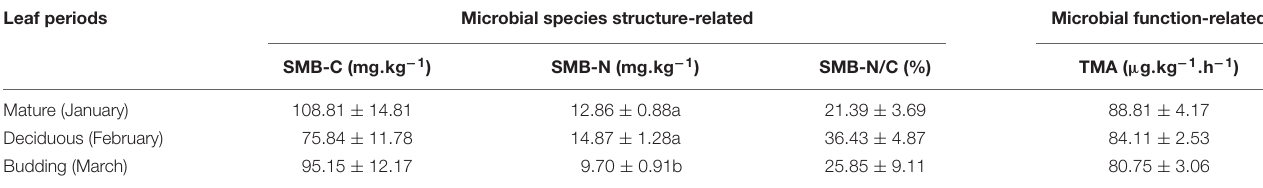
TABLE 2 | Soil microbial-related properties during different leaf periods. Leaf periods Microbial species structure-related Microbial